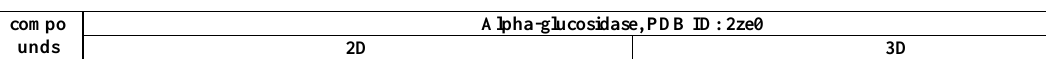
Fig 1. Ligand–Protein 2D and 3D interaction on the active site of 1hny. 363